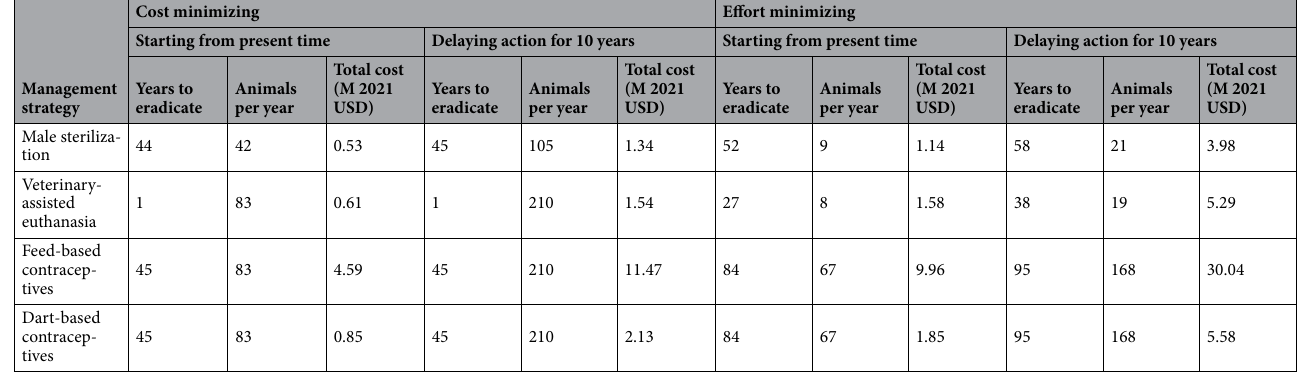
Table 1. Cost minimizing and annual effort minimizing strategies to control introduced hippos in the Magdalena River, Colombia starting from present time or delaying action for a decade. We used the hippopotamus population at the close of 2021, n = 83, to represent the starting population size for management interventions commencing in 2022. Similarly, we used the population abundance at the close of 2031, n = 210, for management interventions commencing a decade out in 2032. Years to eradicate indicates the total years of treatments needed to eradicate the entire population (males and females) once management interventions have